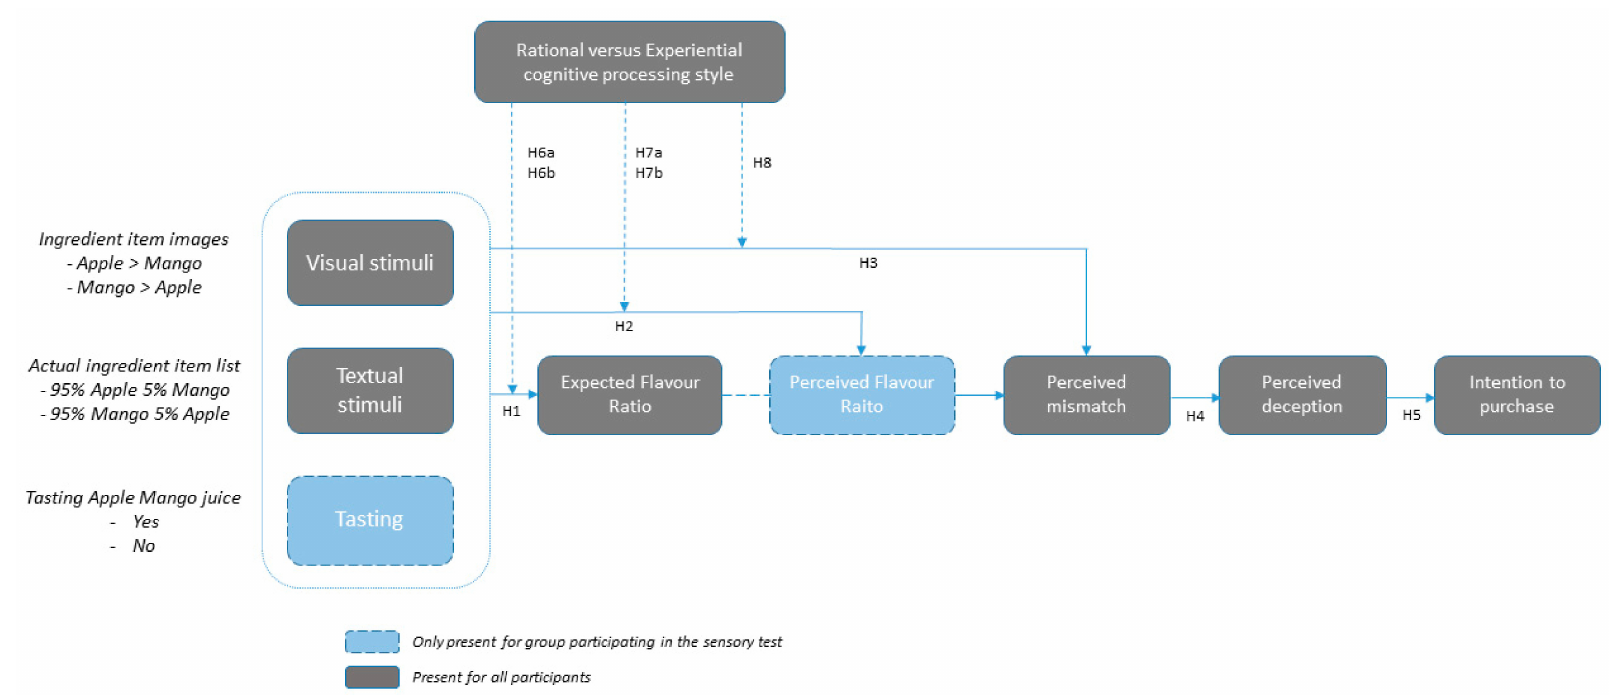
Figure 1. Conceptual model and corresponding operationalization of levels to the